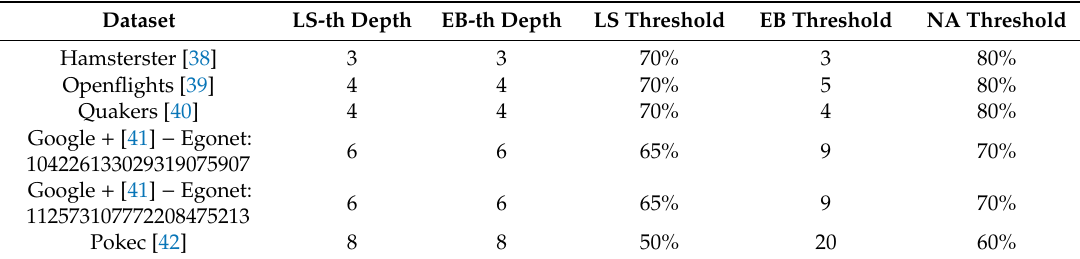
Table 2. The proposed methodology best execution arguments.